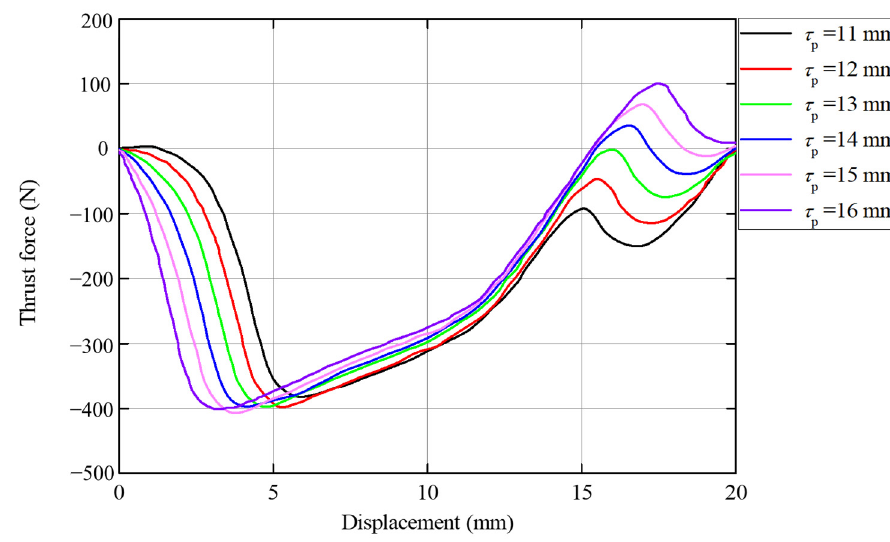
Figure 6. The thrust force waveform variation with the pole-shoe width τ p .